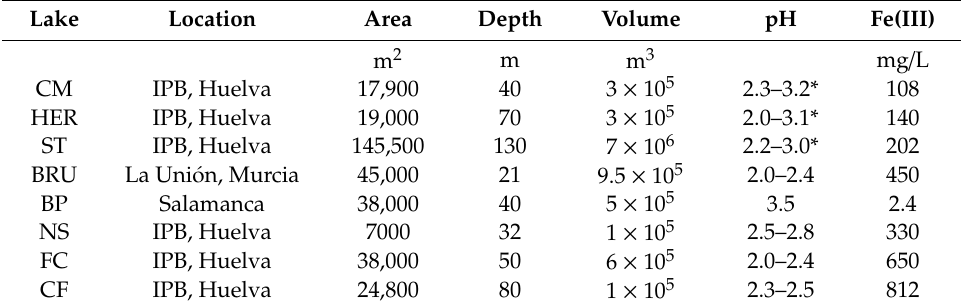
*, pH values refer to the epilimnion and photic zone of the lakes. Abbreviations: CM, Cueva de la Mora; ST, San Telmo; HER, Herrer í as; BRU, Brunita; BP, Barruecopardo; NS, Nuestra Señora del Carmen; FC, Fil ó n Centro (Tharsis); CF,